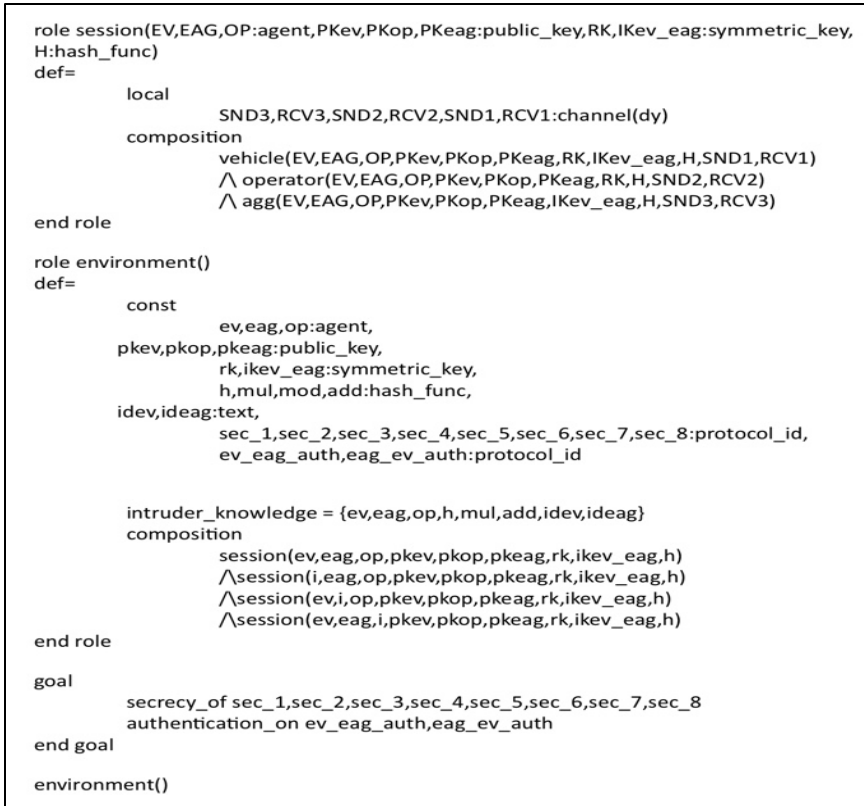
Figure 11. Mutual Authentication Specification of the session and environment.